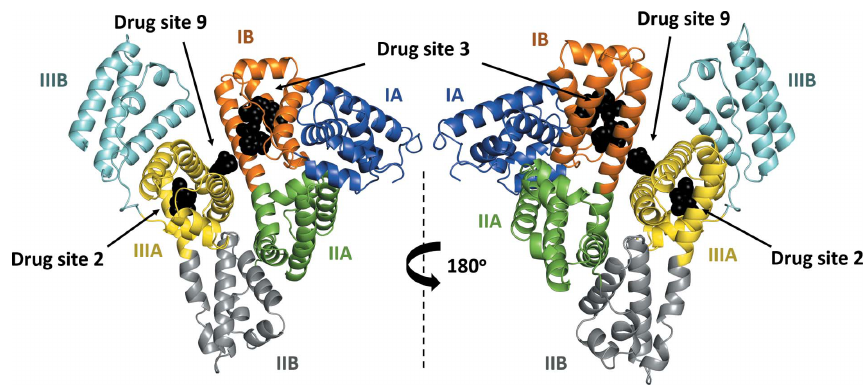
Figure 2 The overall structure of the complex of HSAwith ketoprofen. Albumin subdomains are each shown in a different color. Roman numerals (I, II, III) are associated with domains and letters (for example IB) with subdomains. Ketoprofen molecules are shown with atoms in black spheres.